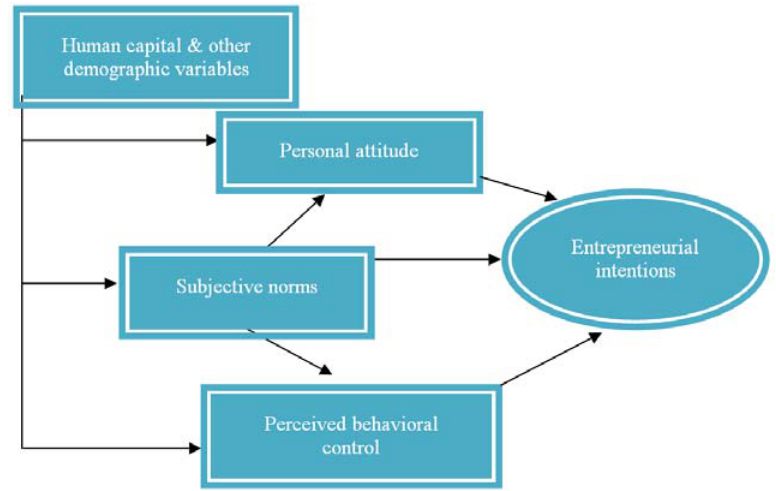
Fig. 1. Entrepreneurial intention